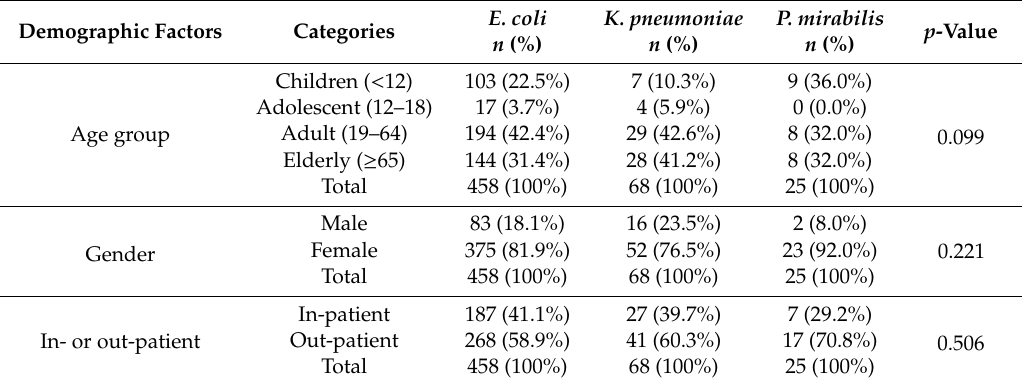
Table 2. Distribution of the three studied uropathogens according to patients’ demographic factors. Chi-squared test was used to evaluate any significant di ff erence between the categorical variables of patients’ demographic factors between the three studied groups ( E. coli , K. pneumonia , and P. mirabilis ). The level of statistical significance was set at p < 0.05.